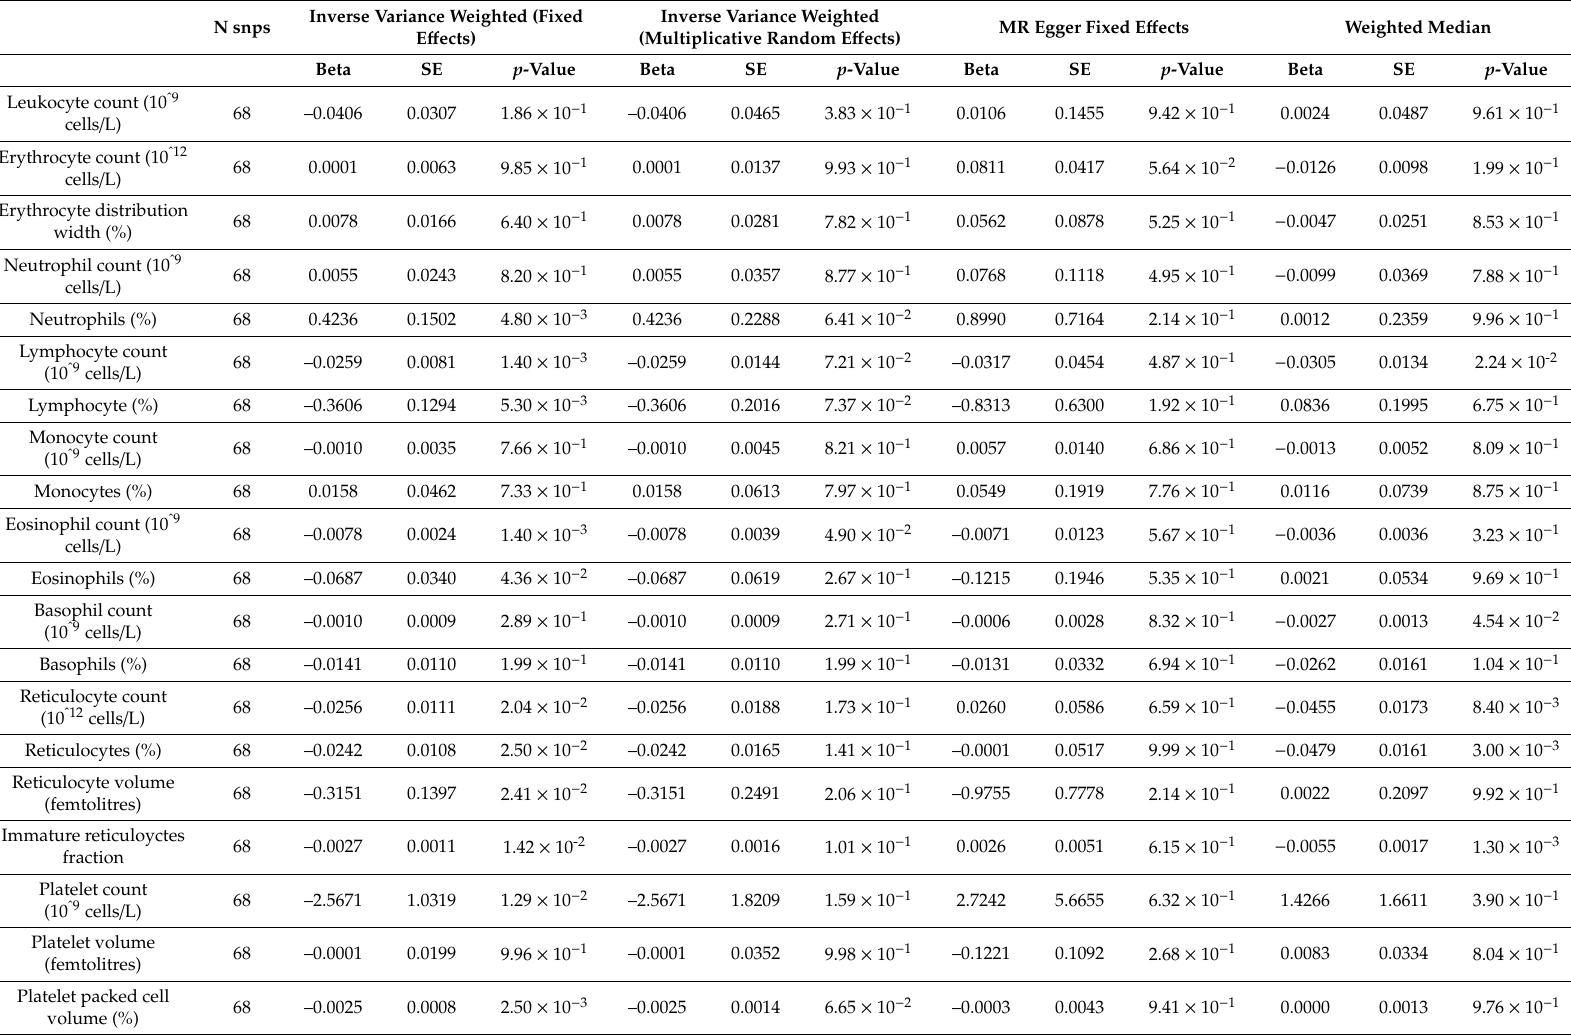
Table 2. Associations between increased physical activity and circulating blood